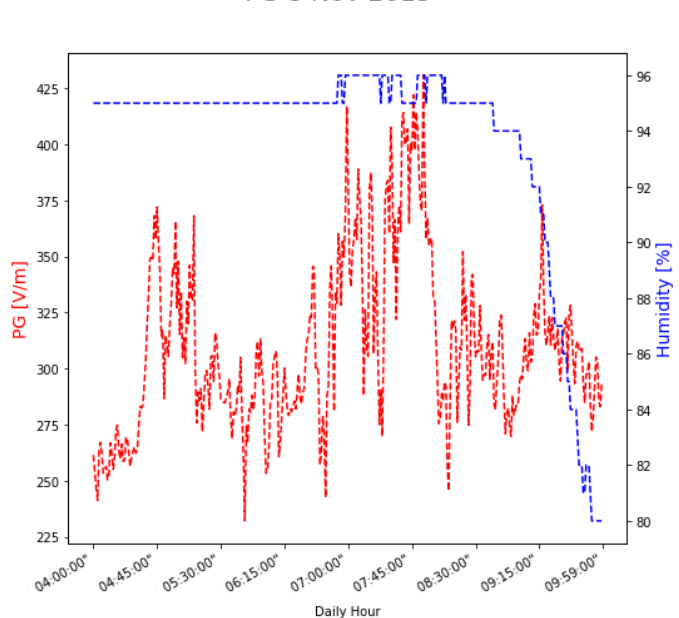
Figure 5. Time dependence of the potential gradient (red) and the relative humidity (blue) for the period 04:00–10:00 local time, on 8 November 2015. Note the decrease in PG that precedes the actual dissipation of fog, manifested by the rapid reduction in relative humidity.